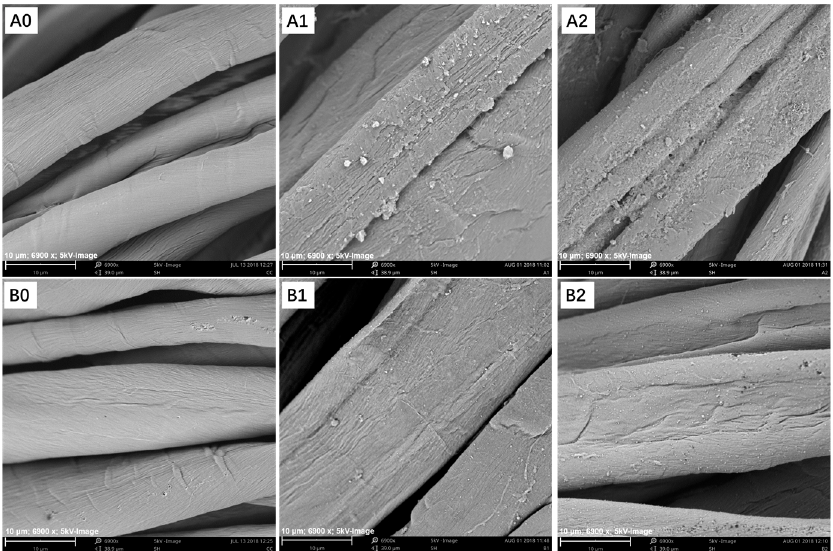
Figure 5. Scanning electron microscope (SEM) images of cotton fabrics coated with polyaniline: ( A0 ) cotton fabric control-water bath; ( A1 ) fabric coated with polyaniline-water bath (no HBT); ( A2 ) fabric coated with polyaniline-water bath (with HBT); ( B0 ) cotton fabric control-ultrasonic bath; ( B1 ) fabric coated with polyaniline-ultrasonic bath (no HBT); ( B2 ) fabric coated with polyaniline-ultrasonic bath (with HBT). Table 2. Elements characterization (on different spots of the sample) on coated and non-coated fabrics, by energy-dispersive X-ray spectroscopy (EDS) analysis. Element Control Fabric Element Element conc. (%) Carbon Atomic conc. Weight conc. Carbon Weight Oxygen conc.